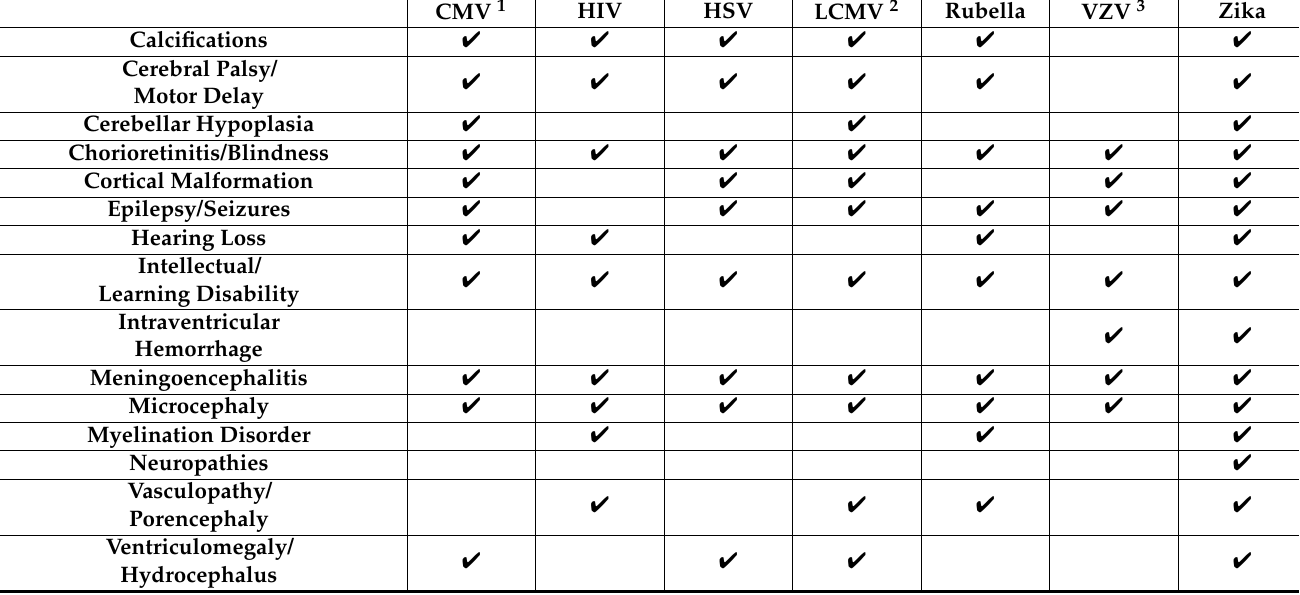
Table 1. Prenatal viral infections lead to overlapping neuropathology and neurodevelopmental disabilities. CMV 1 HIV HSV LCMV 2 Rubella VZV 3 Zika